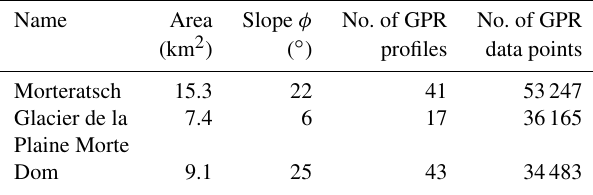
Table 1. Characteristics and data sets of glaciers investigated. Slope φ denotes the average slope